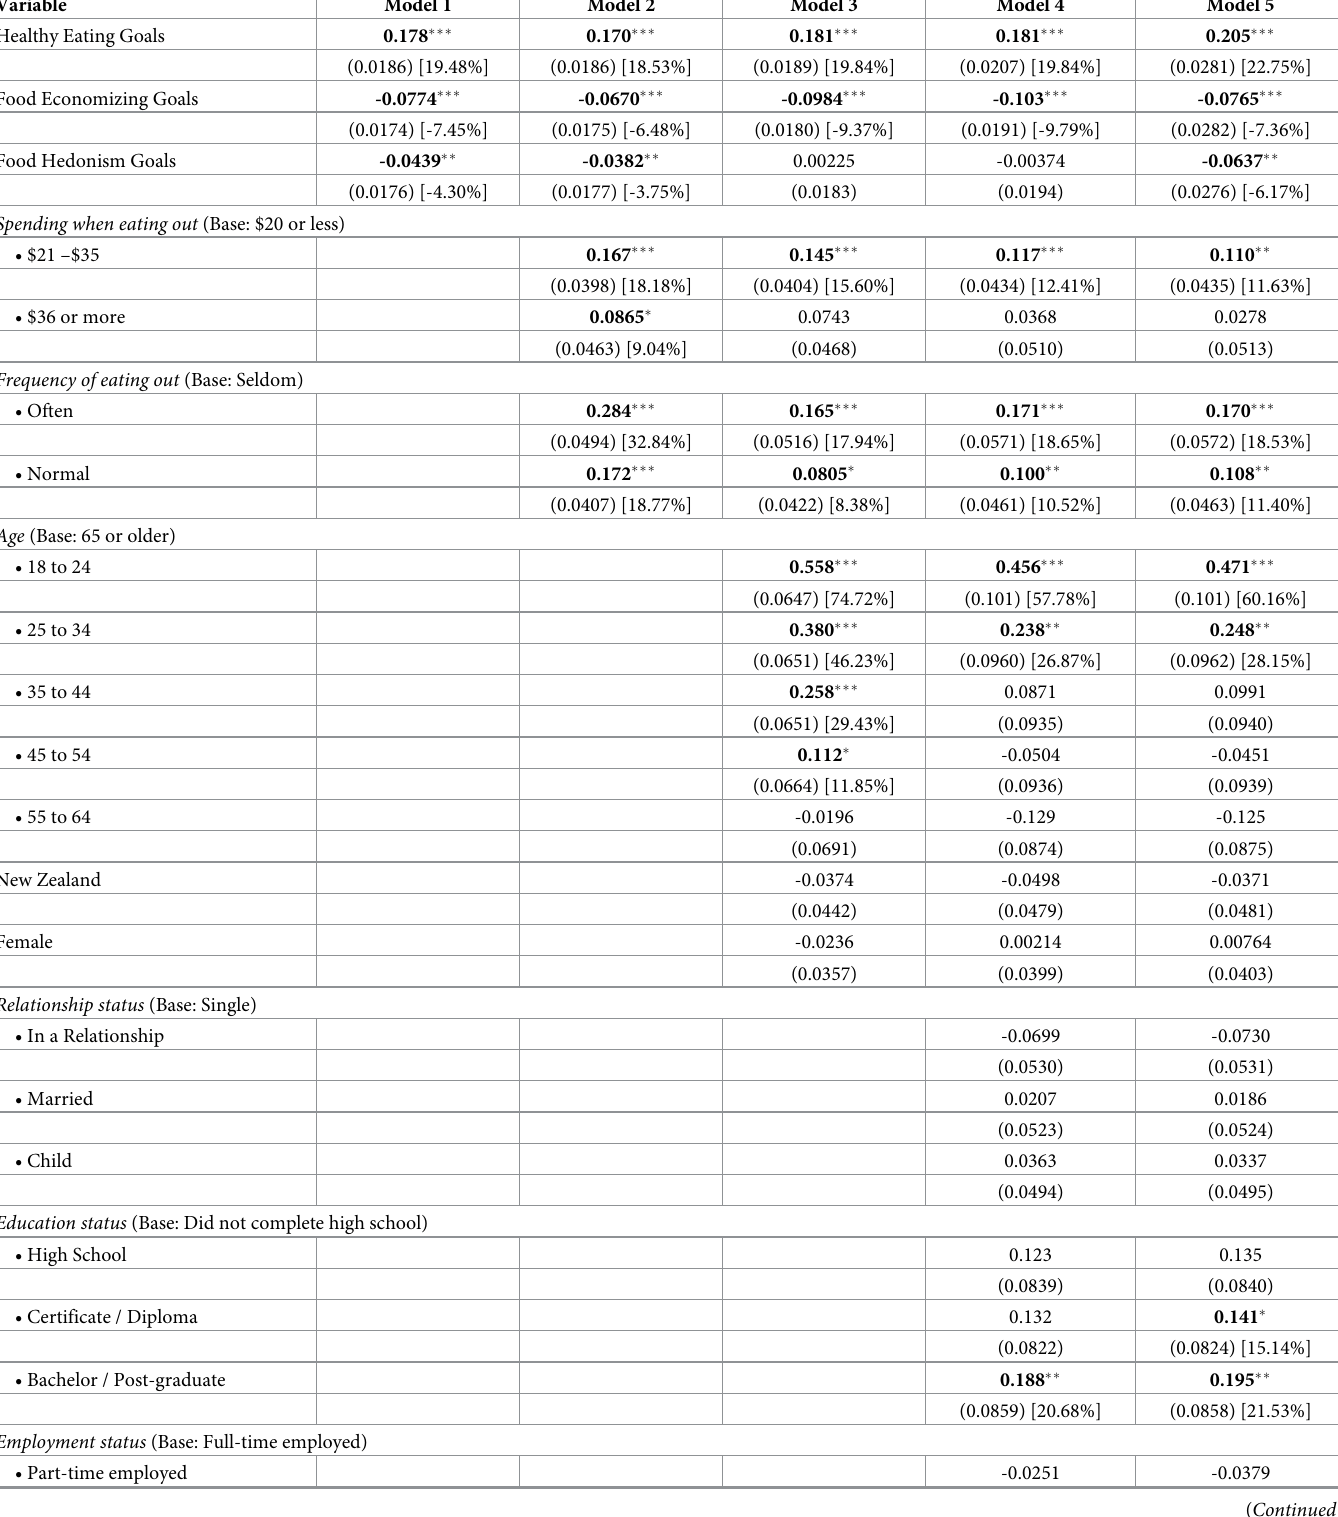
Table 5. Censored Poisson regression results for the determining factors of willingness to pay a premium